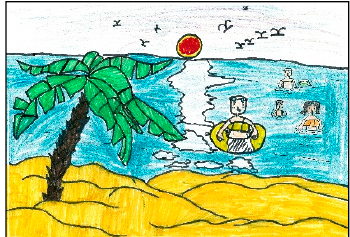
Figure 3. An unsuccessful case of using mosaic painting materials.